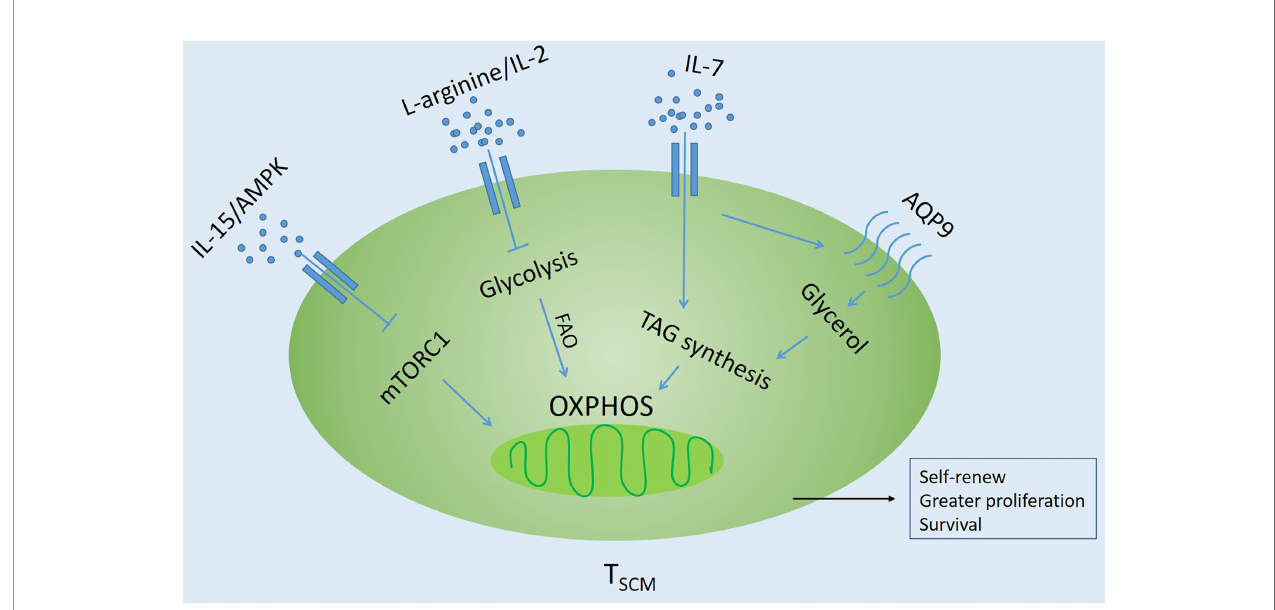
FIGURE 3 | In fl uencing factors regulating oxidative metabolism of T SCM Cells. Inhibit glycolysis through different pathways and promote fatty acid oxidation (FAO)- dependent oxidative phosphorylation (OXPHOS). AQP9, Glycerol channel aquaporin 9; AMPK, AMP-activated protein kinase; TAG, triglyceride; mTORC1, Rapamycin Complex